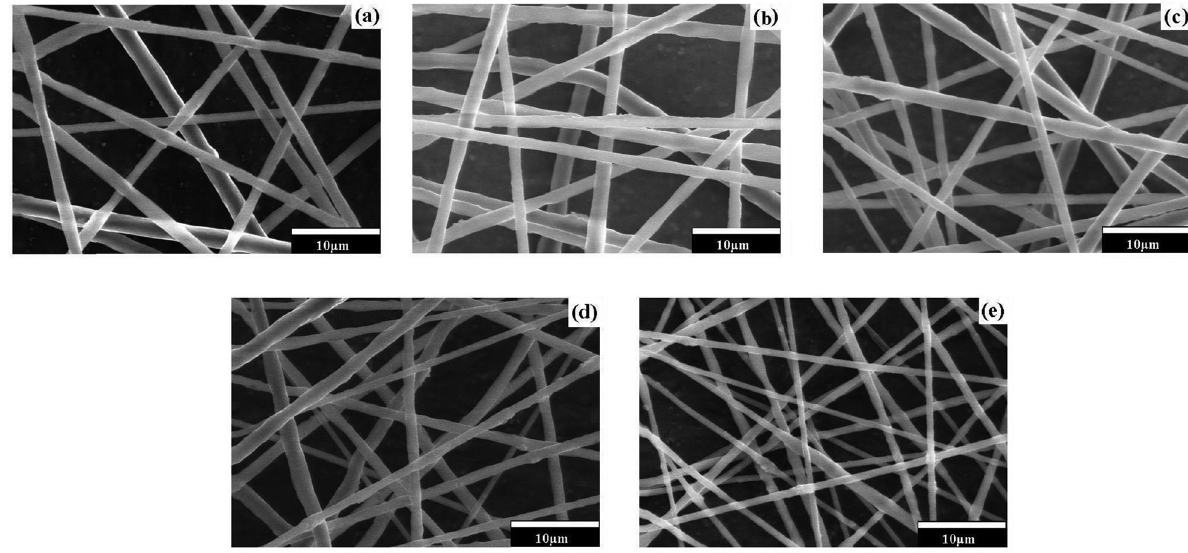
Figure 3: SEM photos of CSBS fi bers prepared at the air pressures: ( a ) 0.007 MPa, ( b ) 0.01 MPa, ( c ) 0.013 MPa, ( d ) 0.016 MPa, ( e ) 0.019 MPa.